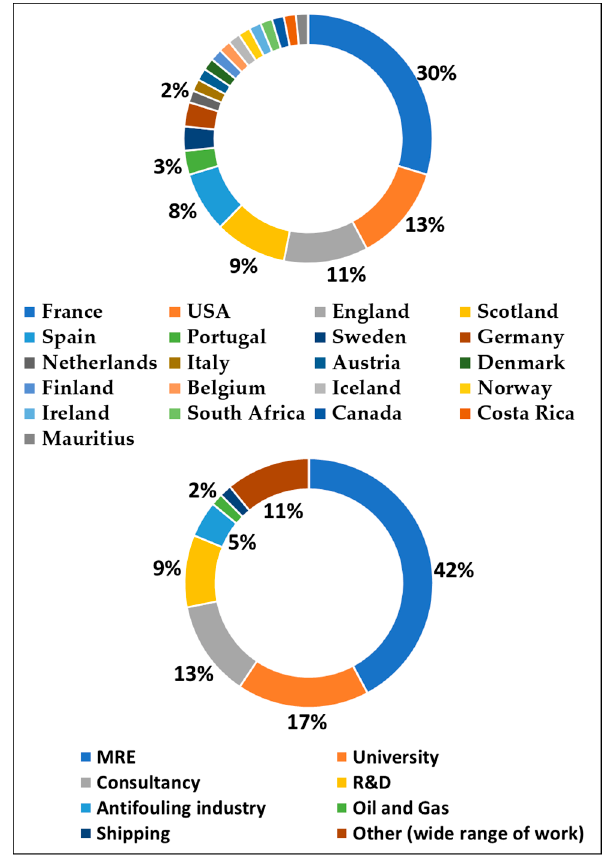
Figure 7. Distribution of the biofouling database downloads among countries and among sectors. Table 2. Regions included in the European biofouling database.